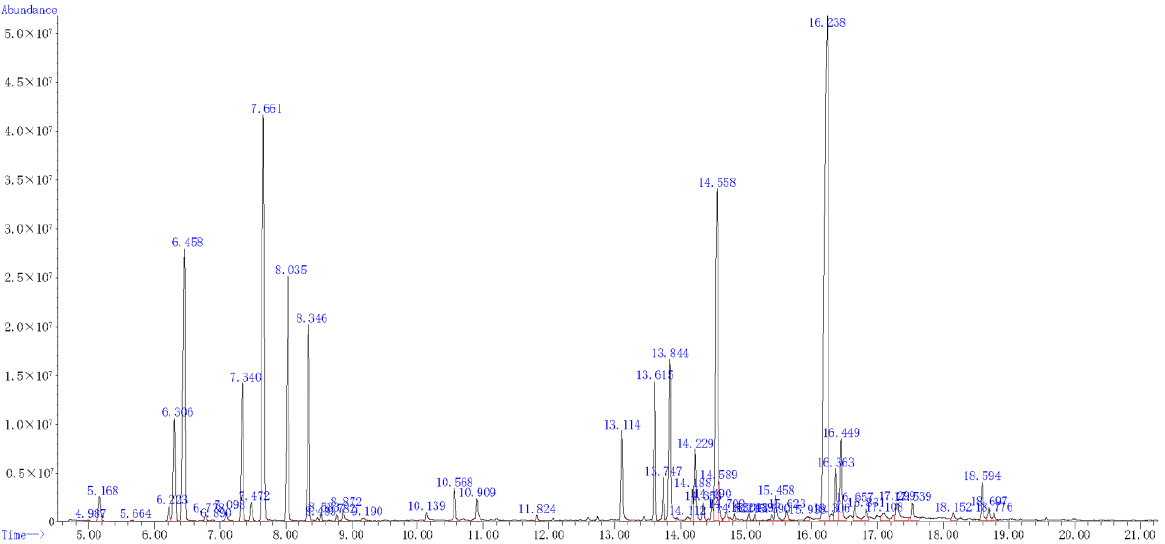
Figure 3. Total iron current chromatogram of the essential oil from A. scoparia.